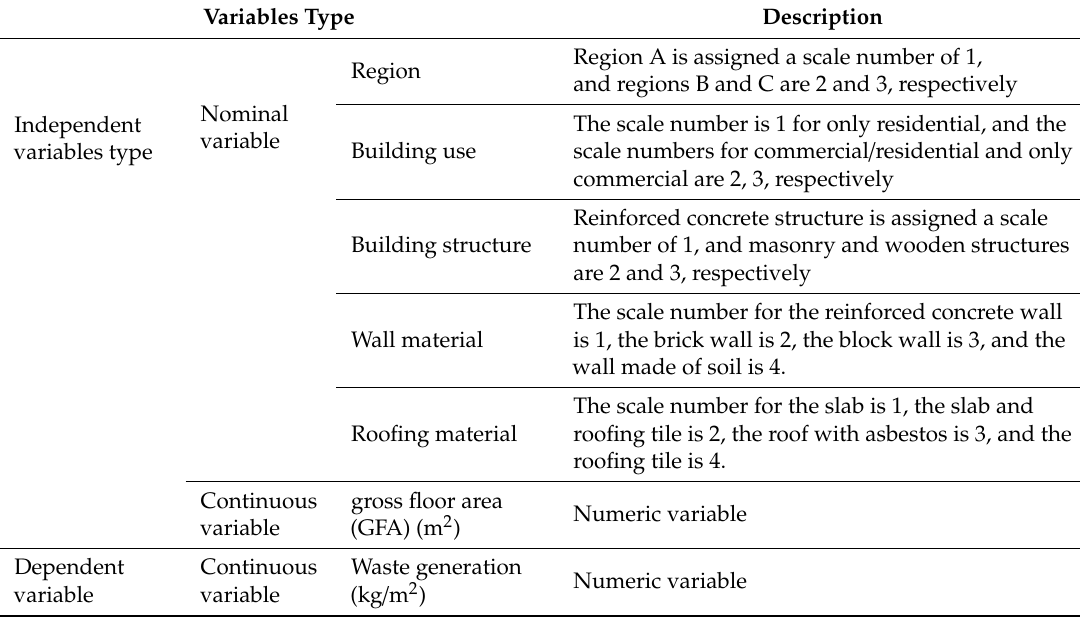
Figure 3. The methodology of the RF model developed in this study. Table 1. Characteristics and composition of variables applied to the RF model in this study.